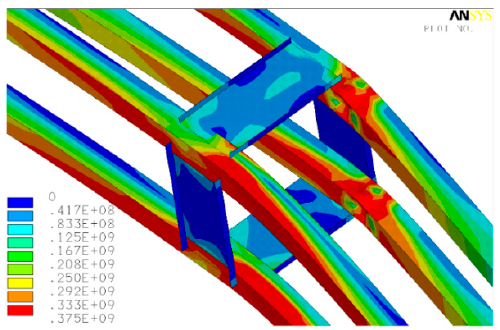
Figure 13. Plastic depressed deformation and Mises stress of tubes (unit: N/m 2 ).